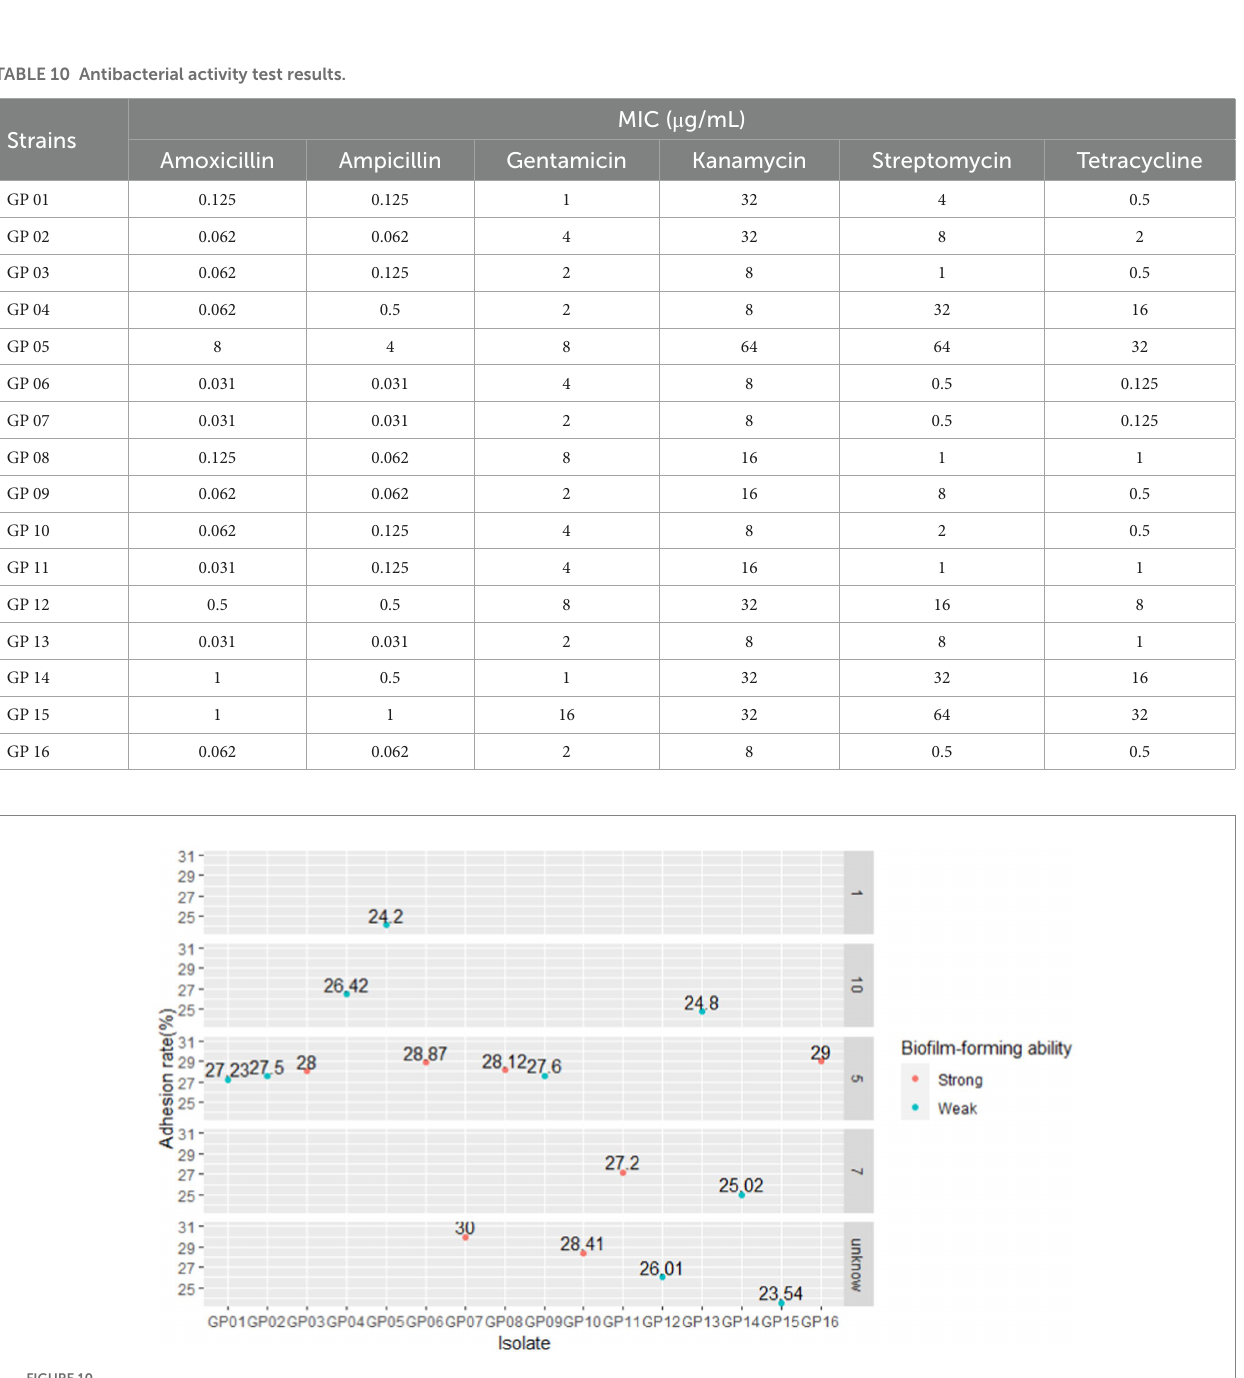
FIGURE 10 Comparison of adhesion rates of different isolates. We faceted the graphs according to the serotypes of the 16 isolates. According to the absorbance of different isolates (Table 9), with an OD630 value threshold of 0.5, it was divided into strong biofilm-forming strains and weak biofilm-forming strains, and the color was